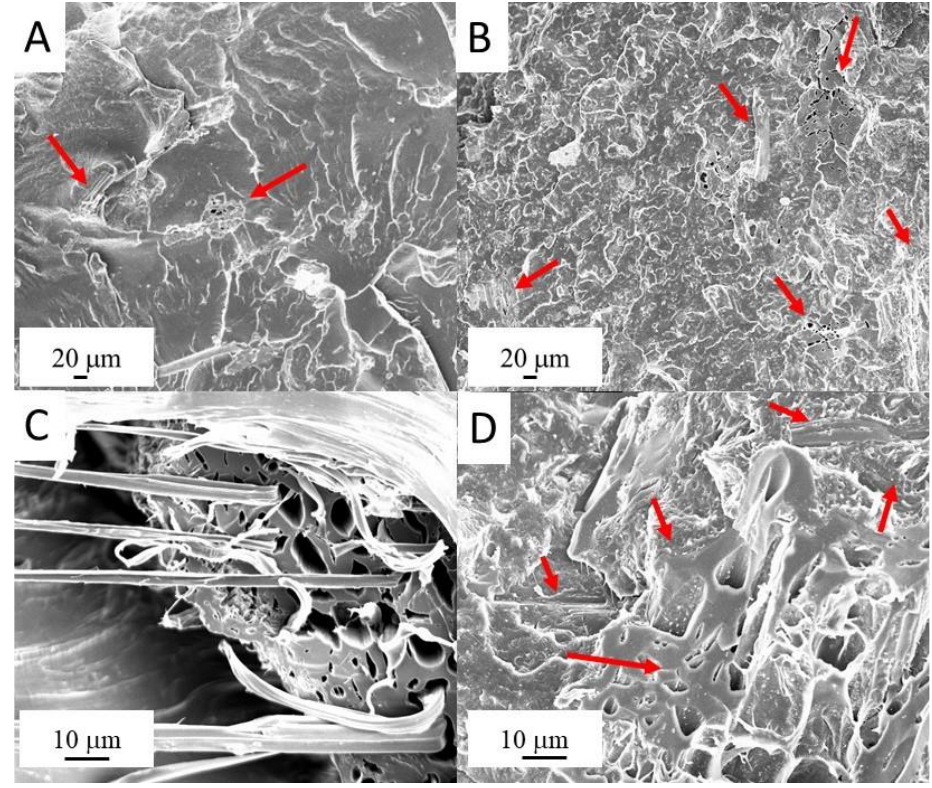
Figure 1. SEM micrographs of EVA/HFB 95/5 ( A , C ) and EVA/HFB 60/40 ( B , D ) cryogenically fracture surfaces.